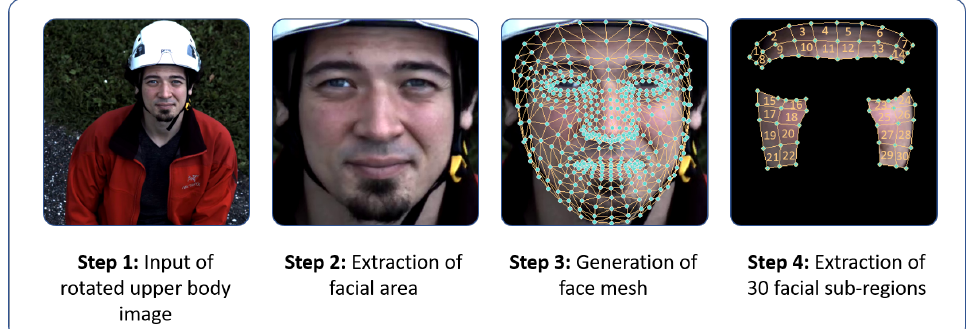
Figure 3. Individual steps for facial ROI selection and